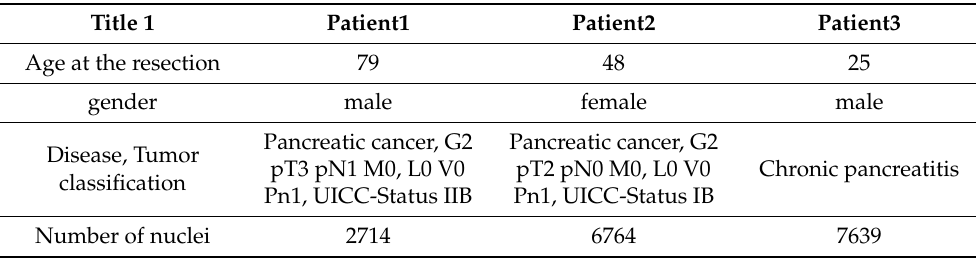
Figure 4. Immunocytochemistry of KRT19 in disease-associated fibroblasts from pancreatic cancer and chronic pancreatitis patients. ( A ) from patient1, ( B ) from patient2, and ( C ) from patient3. Bar: 50 µ m. Table 1. Information of the patients and analyzed number of single